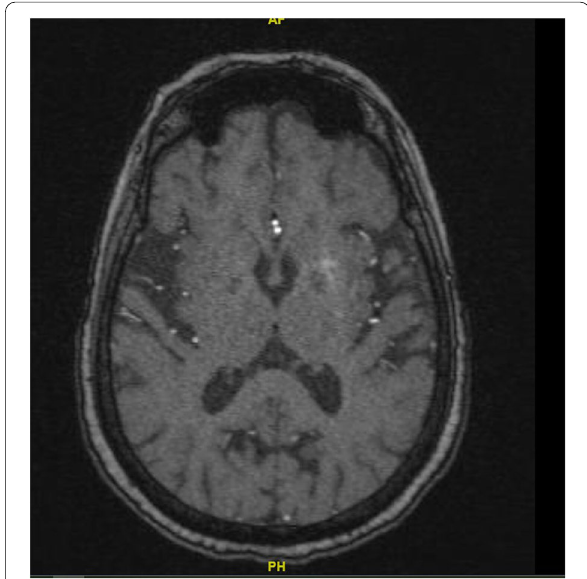
Fig. 1 MRI brain–T1-weighted image reveals hyperintensity involving left